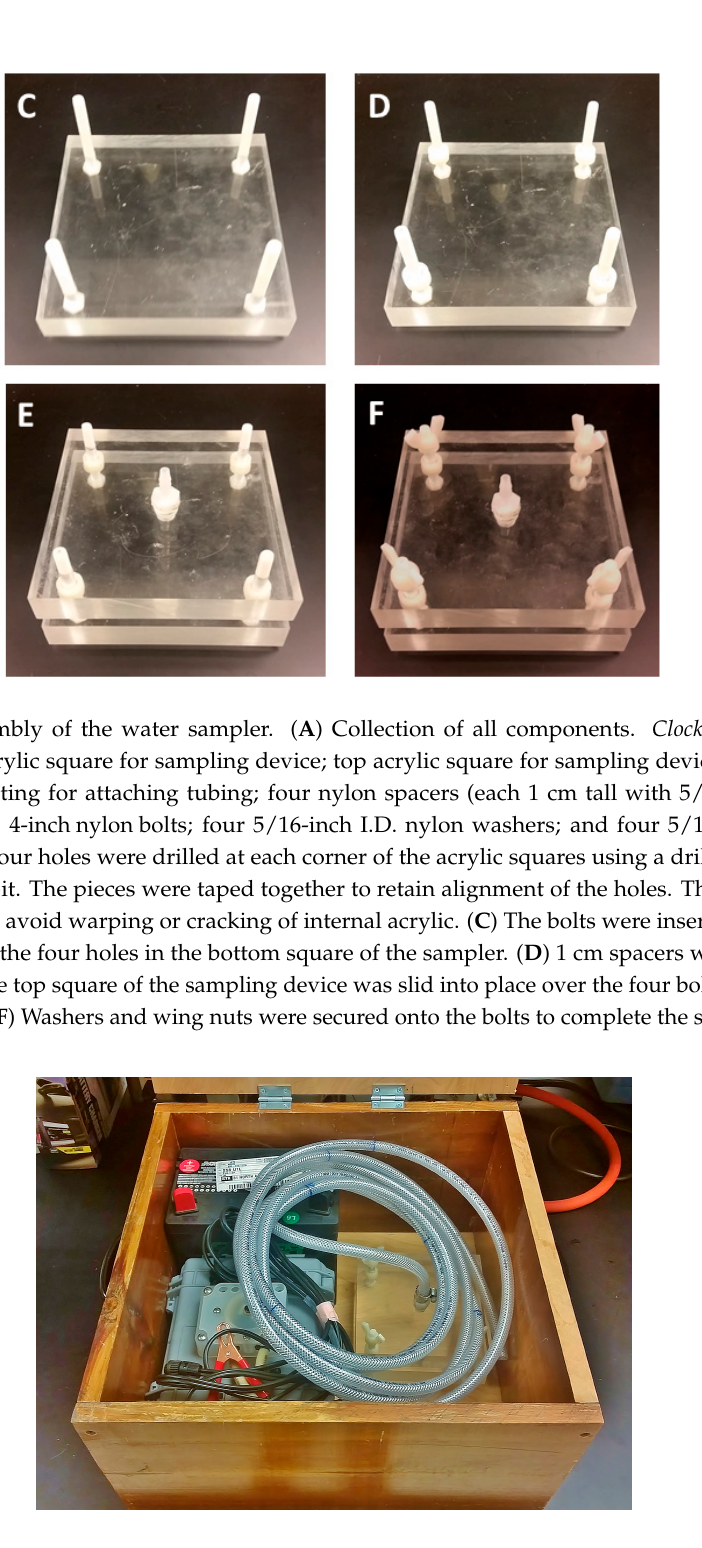
Figure 2. Transporting the water sampler. The sampler (with tubing), peristaltic pump, and battery all fit into a single container, and the total weight of the kit was approximately 30 lbs (13.5 kg). In this case, the container in which all components were placed was a simple wooden box with dimensions of 16½ × 16¾ × 8 inches (42 cm × 42.5 cm × 20.3 cm). Carrying handles were installed on each side of the box to transport the kit. The cost to build the transporter was less than $20 (USD).